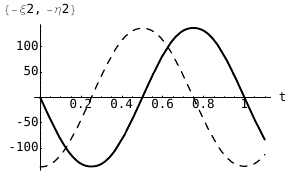
Figure 5. Another 1 -type so- lution of the problem (5.1).